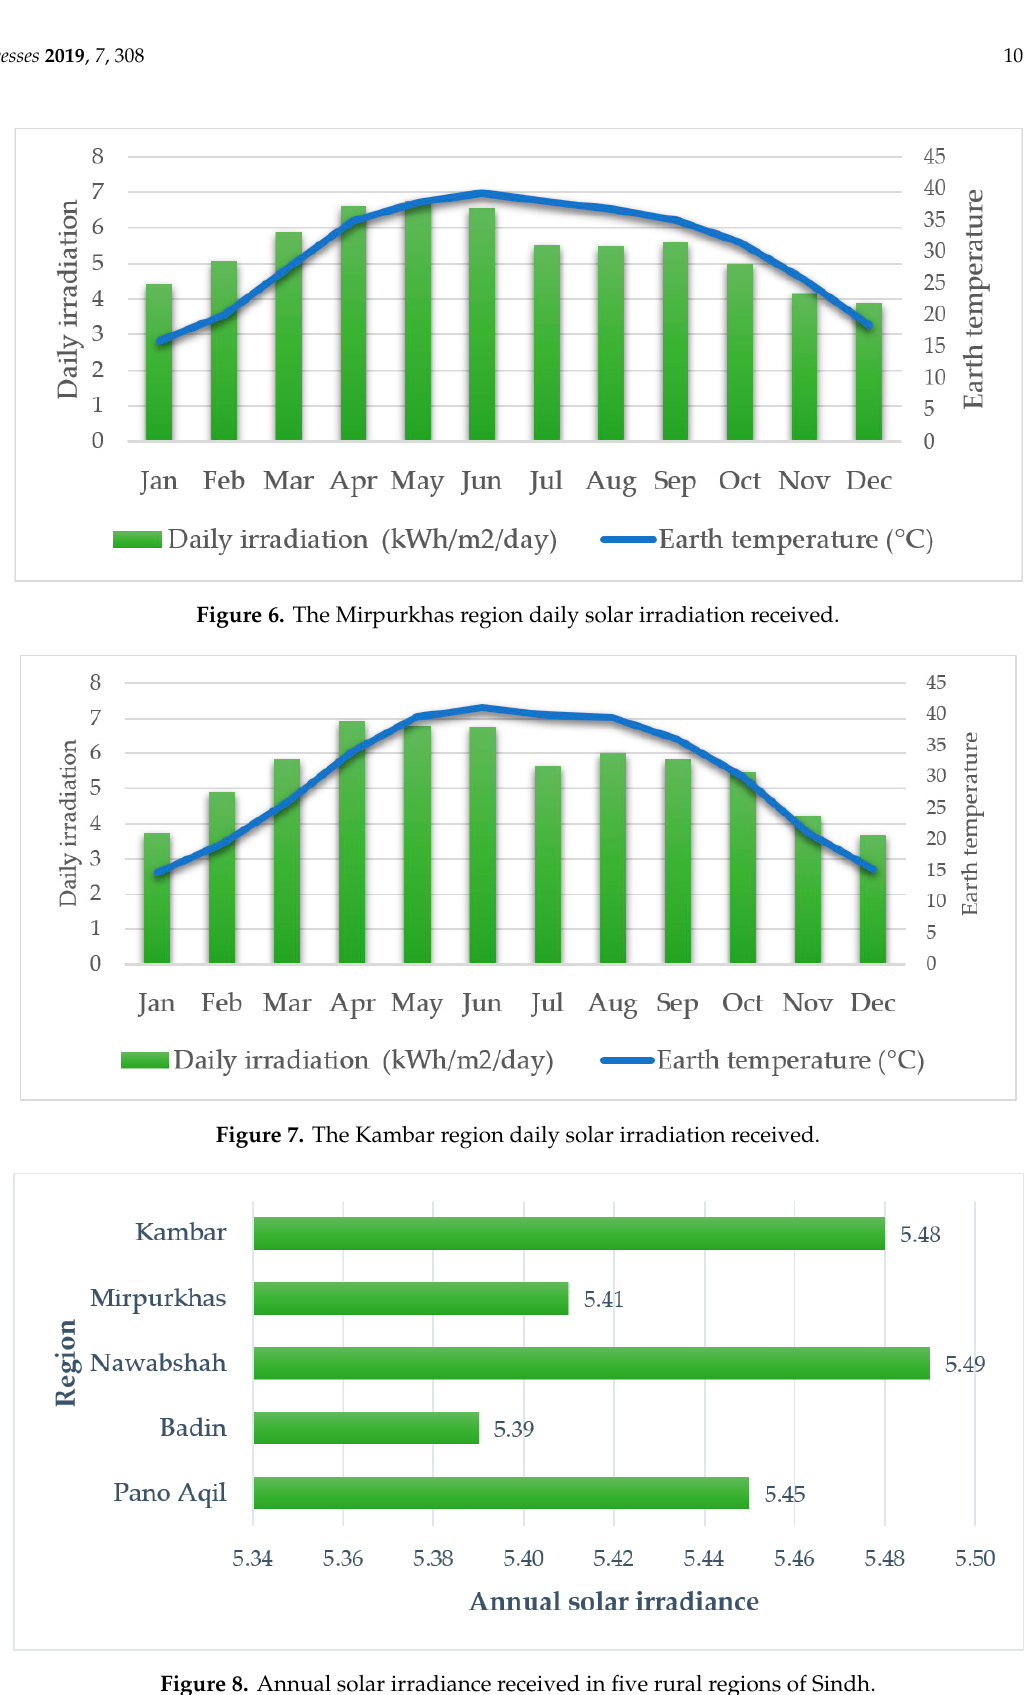
Figure 8. Annual solar irradiance received in five rural regions of Sindh.